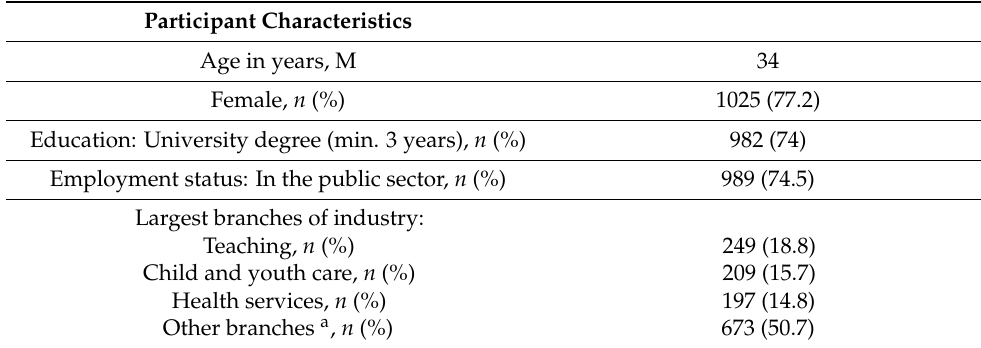
Table 1. Characteristics of study participants in the anonymously completed self-report survey in the Faroe Islands conducted from 13 April 13 until 4 May 2020, n =